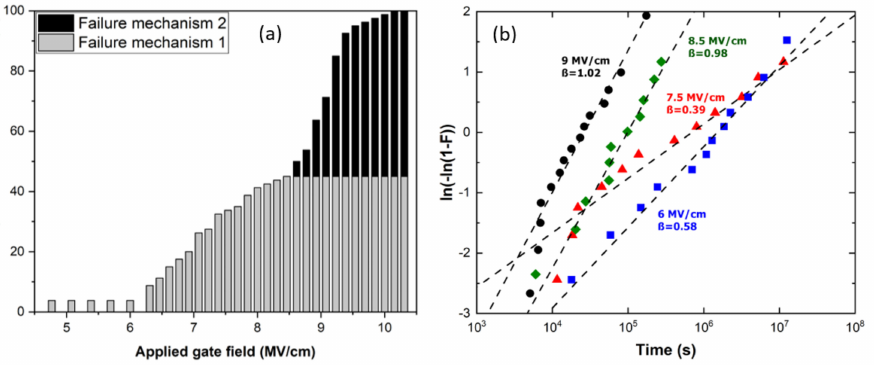
Figure 9. ( a ) Failure distribution of 3C-SiC MOS capacitors in the electric field range of